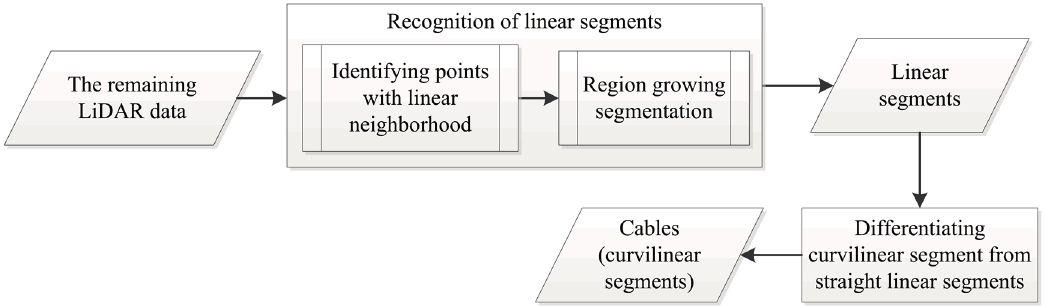
Figure 7. Flowchart of cable